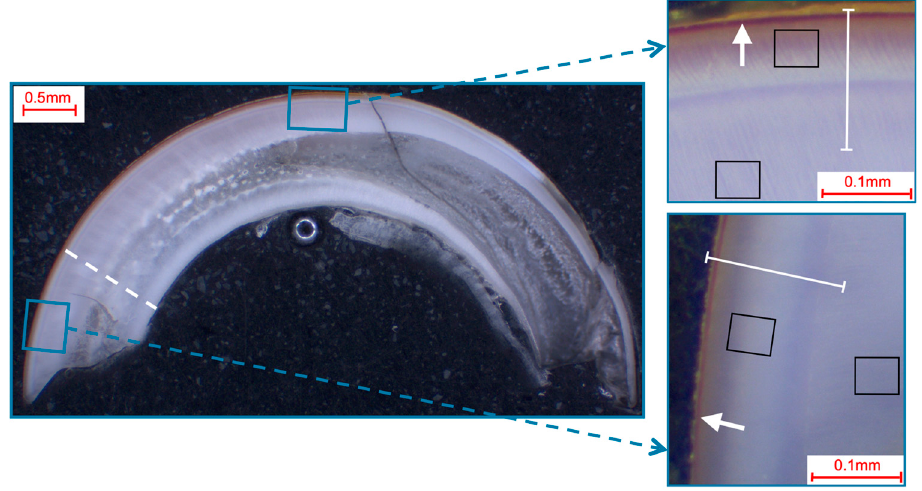
Figure 1. Selection of fields and line-scans for the elemental analysis in murine incisors shown in a photo-microscopic overview. The black squares indicate the 49 µm × 39 µm areas of the field scans, while the white lines indicate the paths of the line scans (length: approximately 140 µm). The white dotted line shows the pre/post-eruptive border, with the pre-eruptive scan area being enlarged in the top right and the post-eruptive scan area being enlarged in the bottom right picture. All pictures showed a yellow-brownish enamel, which is indicative of iron in the superficial enamel (white ar- rows).